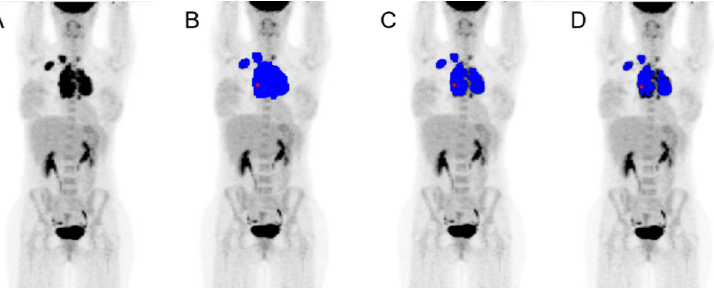
Figure 1. Threshold comparison using BI, ( A ) baseline, ( B ) 2.5 SUV, ( C ) 41% SUV max and ( D ) 50% SUV max